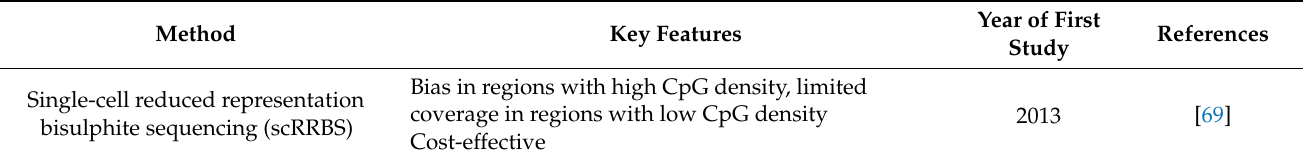
Table 2. Single-cell methylome sequencing techniques. Adapted from Kashima et al. (2020) [72].